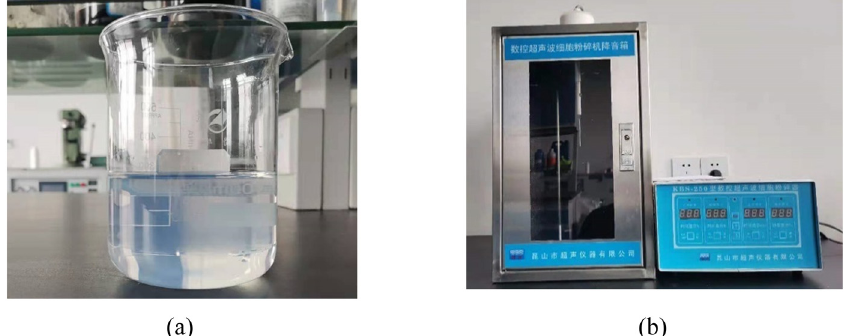
Figure 1: NS ultrasonic dispersion and ultrasonic dispersion equipment. ( a ) NS ultrasonic dispersion. ( b ) Numerical control ultrasonic Cell